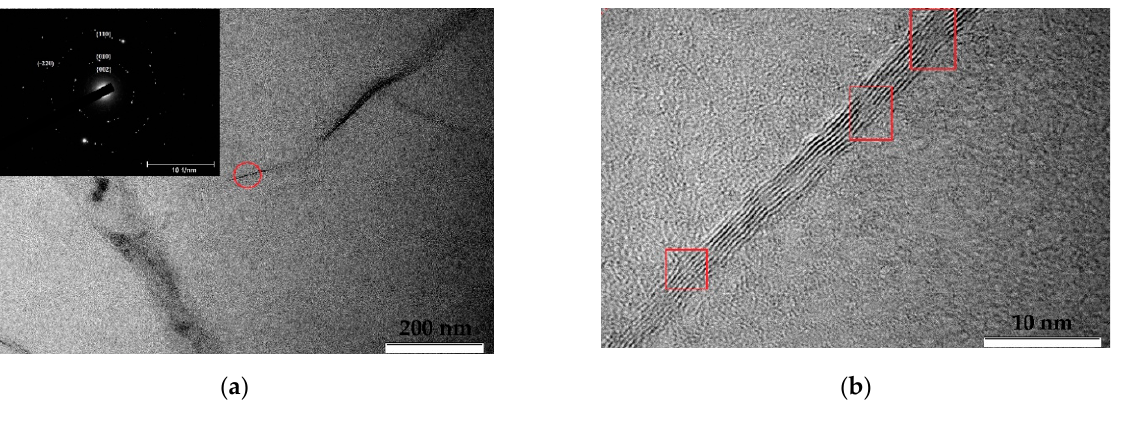
Figure 5. ( a ) TEM images of MLG irradiated by 30 keV Ar+ at ~10 14 ion/cm 2 . On the inset the diffrac ‐ tion pattern; ( b ) the edge of a folded region. The inset shows the diffraction pattern of a folded region highlighted by the red rectangles; ( b ) High Resolution TEM image of the edge of a folded region. Traces of penetration of argon clusters through MLG are highlighted by a red